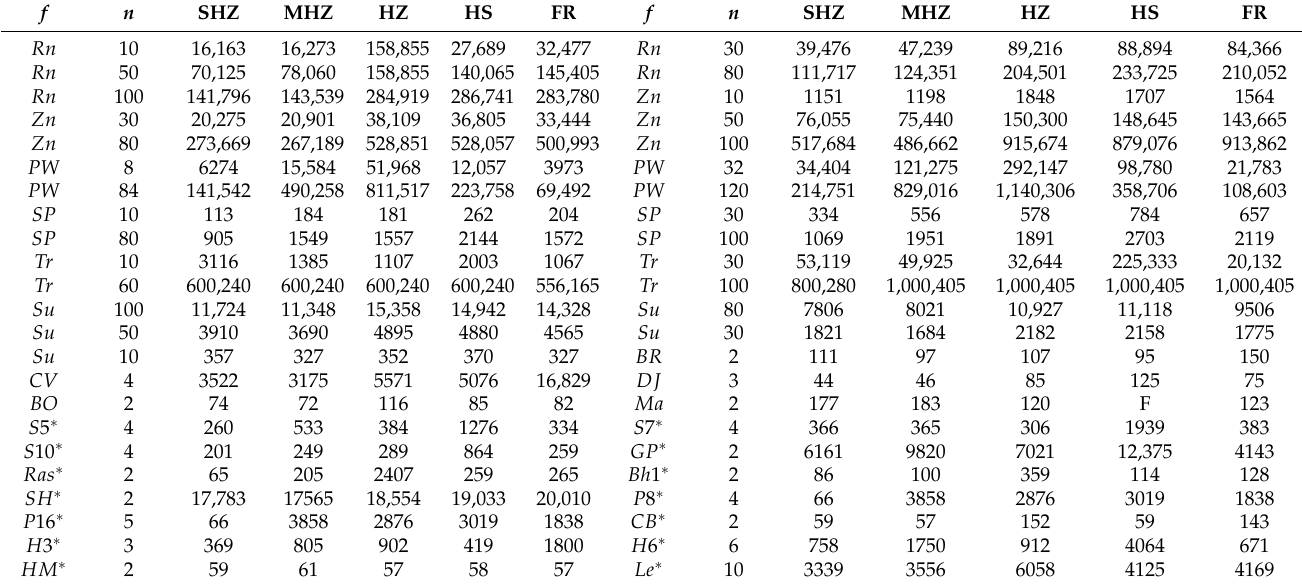
Table 8. The average of number of function